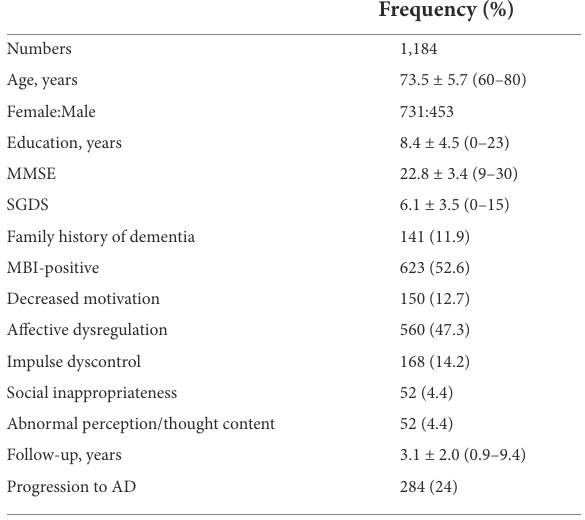
TABLE 1 Demographic and clinical characteristics of the study participants at baseline.